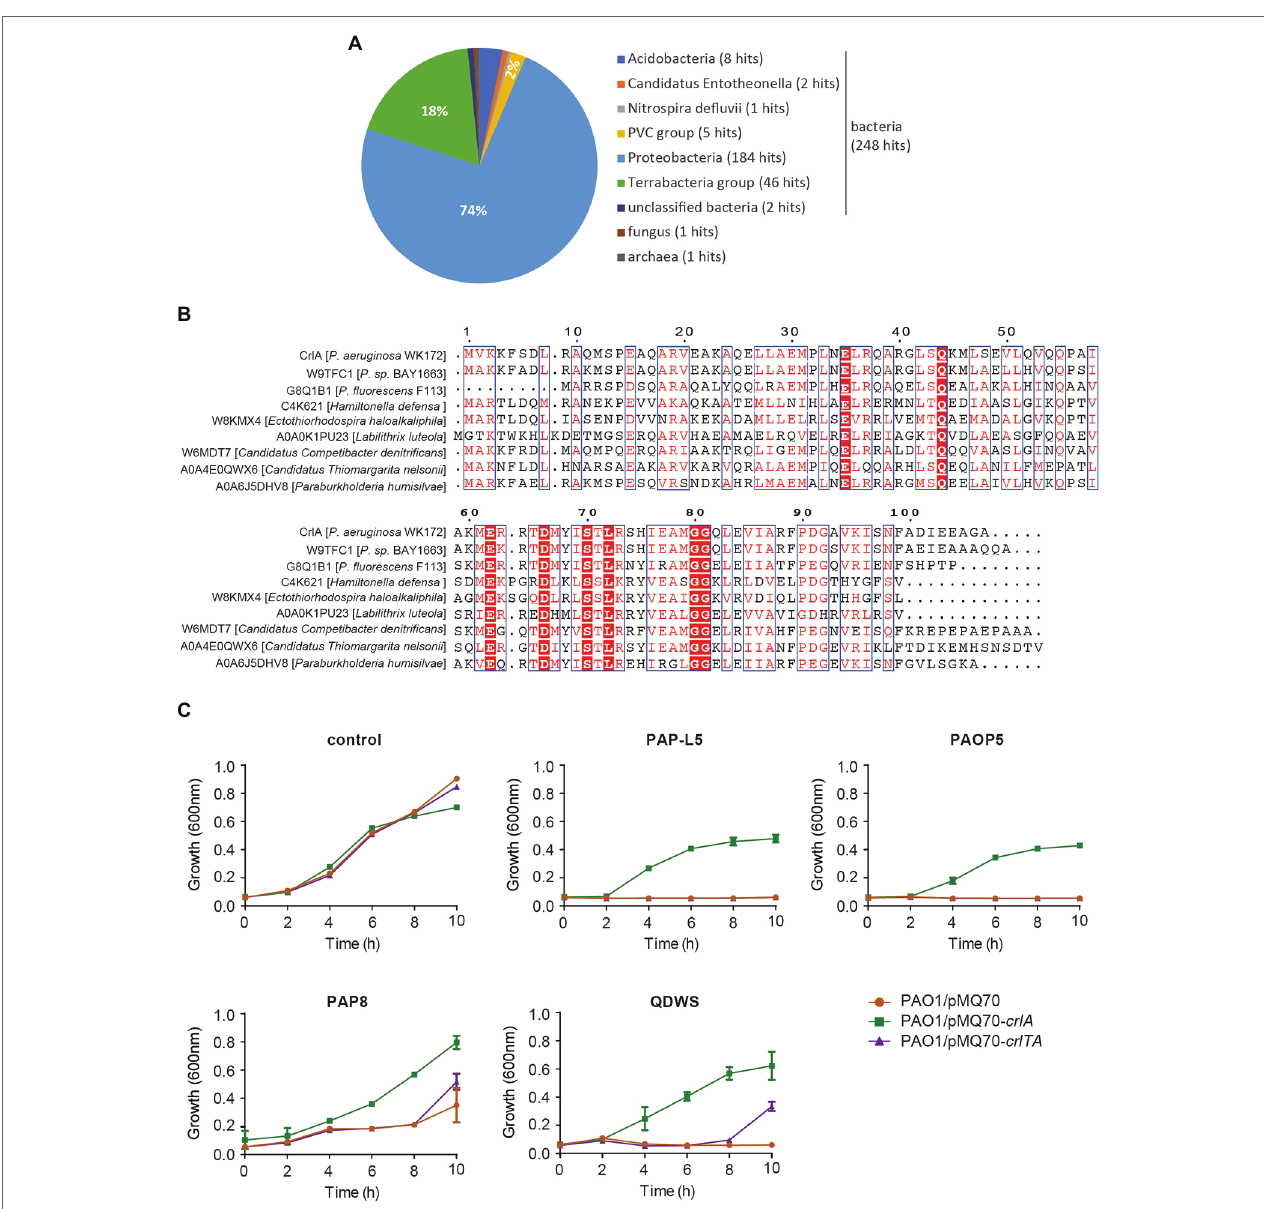
FIGURE 5 | CrlA confers resistance to lytic Pseudomonas phages. (A) Distribution of CrlA homologs identified in UniProt database. (B) Alignment of amino acid sequences among CrlA and 7 other Cro-like proteins from different bacterial species was performed based on the Dense Alignment Surface method (http://www. sbc.su.se/~miklos/DAS/). The predicted conserved regions are shown in red letters with blue boxes, and the red highlighted amino acids indicate the highly conserved sites in these proteins. (C) Culture dynamics of phage-infected cells harboring pMQ70, pMQ70- crlA , and pMQ70- crlTA in the PAO1 host. Phages were mixed with cells in culture containing 10 mM L -arabinose inducer, and the growth of cells was monitored at the indicated time points. Three independent cultures for each strain were used, and error bars indicate the standard error of the mean ( n =